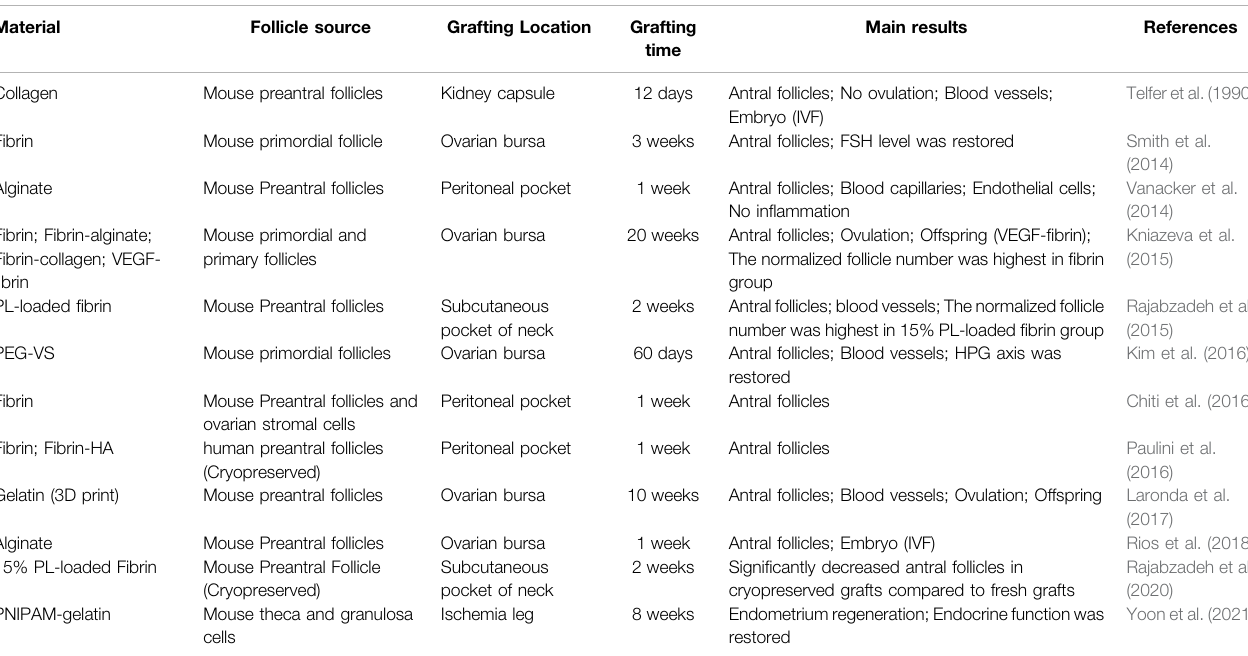
TABLE 2 | Animal experiments on arti fi cial